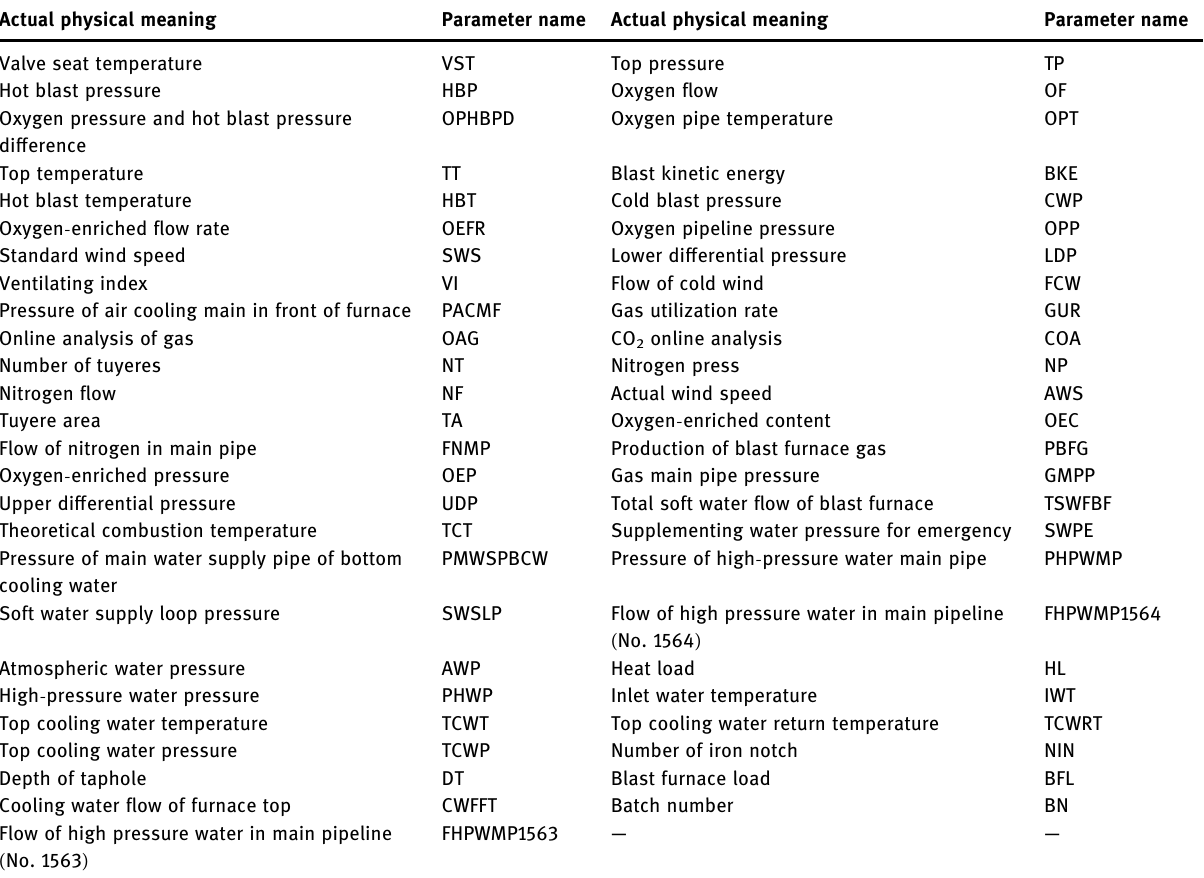
Table 2: Correspondence between actual physical meaning and parameter